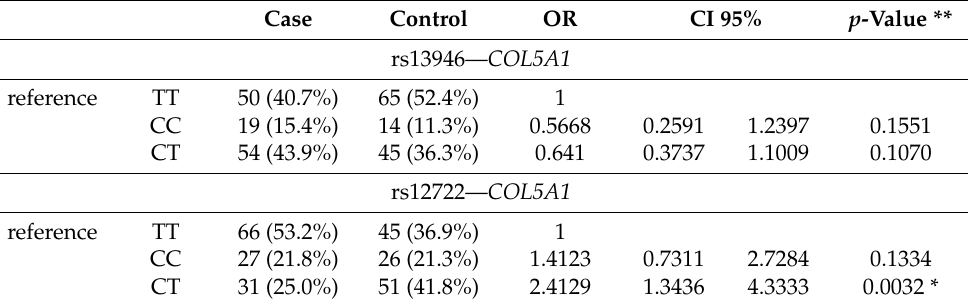
Table 2. Odds ratio analysis.